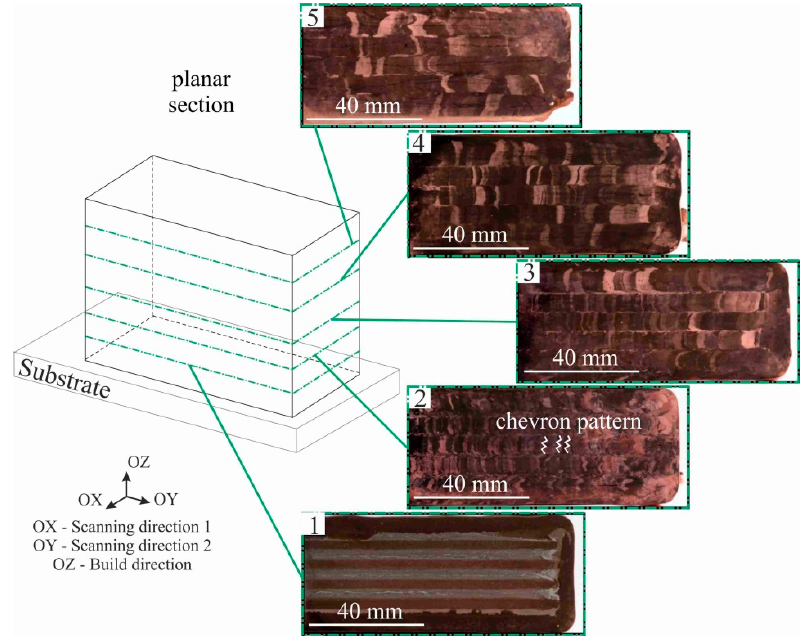
Figure 8. Macrostructure of the C-type copper block in planar section. The green dotted lines show areas of distance from the substrate—area 1: 1.5 mm, area 2: 3 mm, area 3: 4.5 mm, area 4: 6 mm, area 5: 7.5 mm. The white line shows the chevron pattern structure.